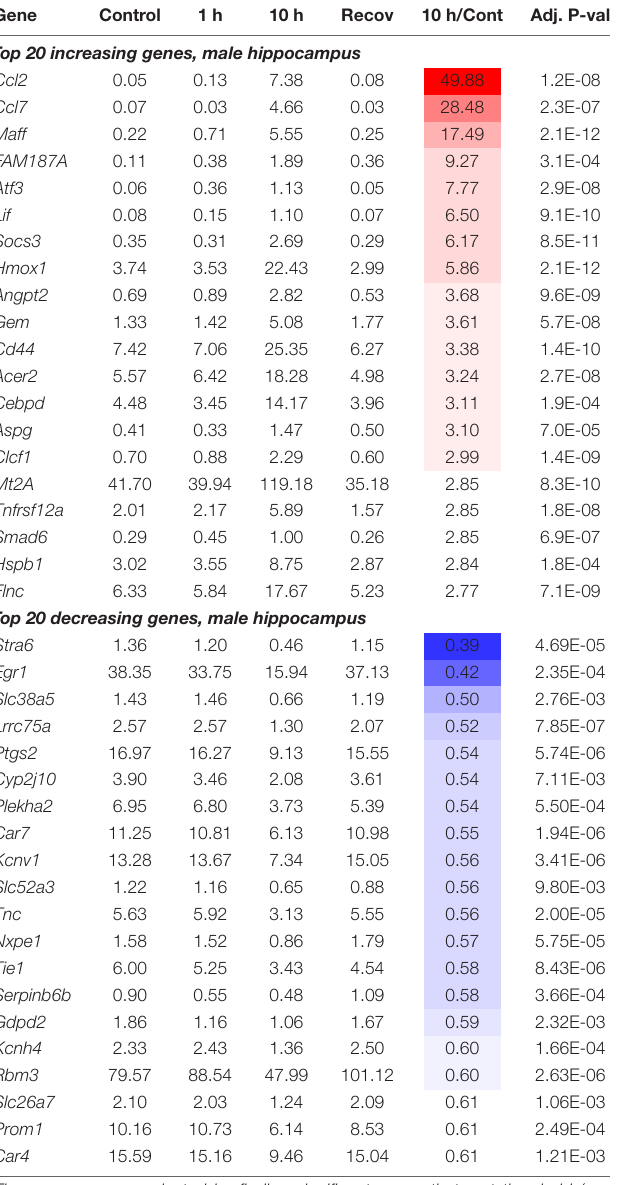
shown at the bottom (blue flame